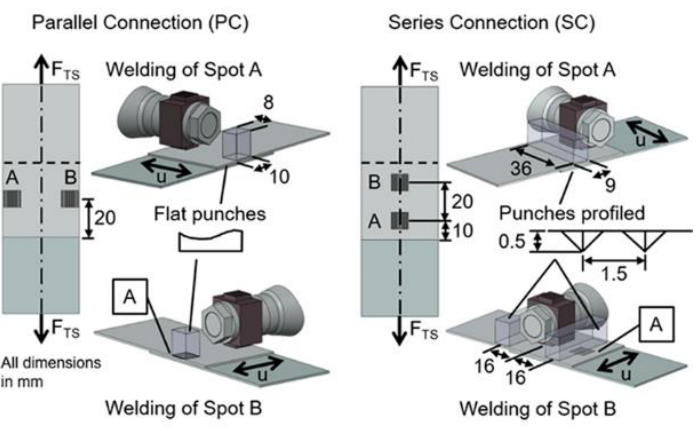
Figure 32. Schematic diagram of multi-spot USW [46].